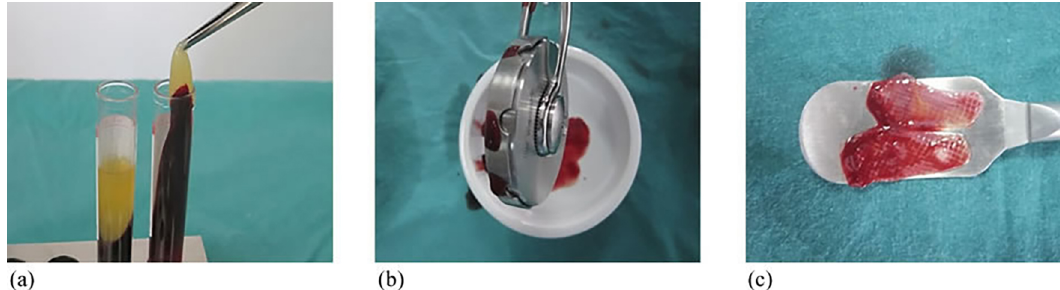
Figure 1- Concentrated growth factor (CGF). (a) Clots form and centrifuge tubes. (b) A special compressor. (c) CGF membranes